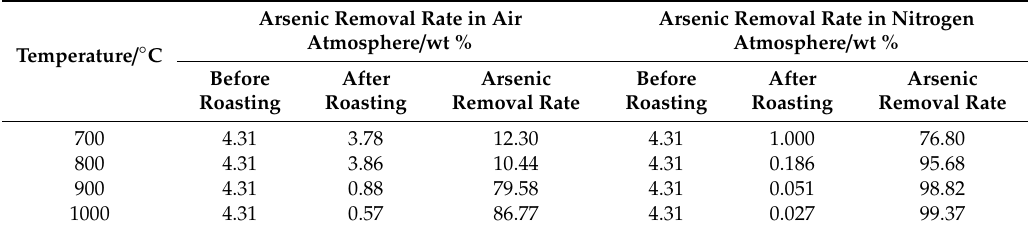
Table 3. Arsenic removal rate of ore subjected to roasting.